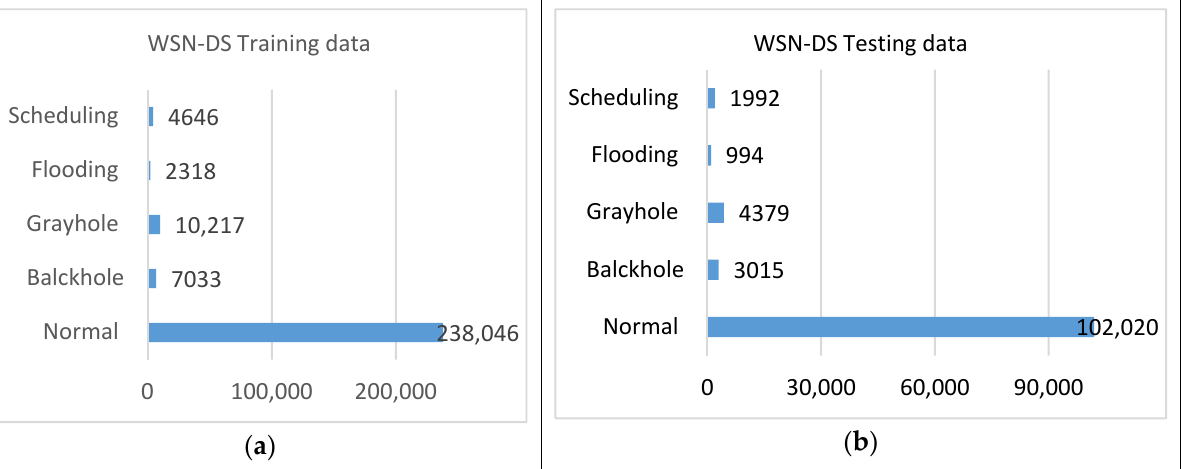
Figure 8. WSN-DS ( a ) training data and ( b ) testing data.